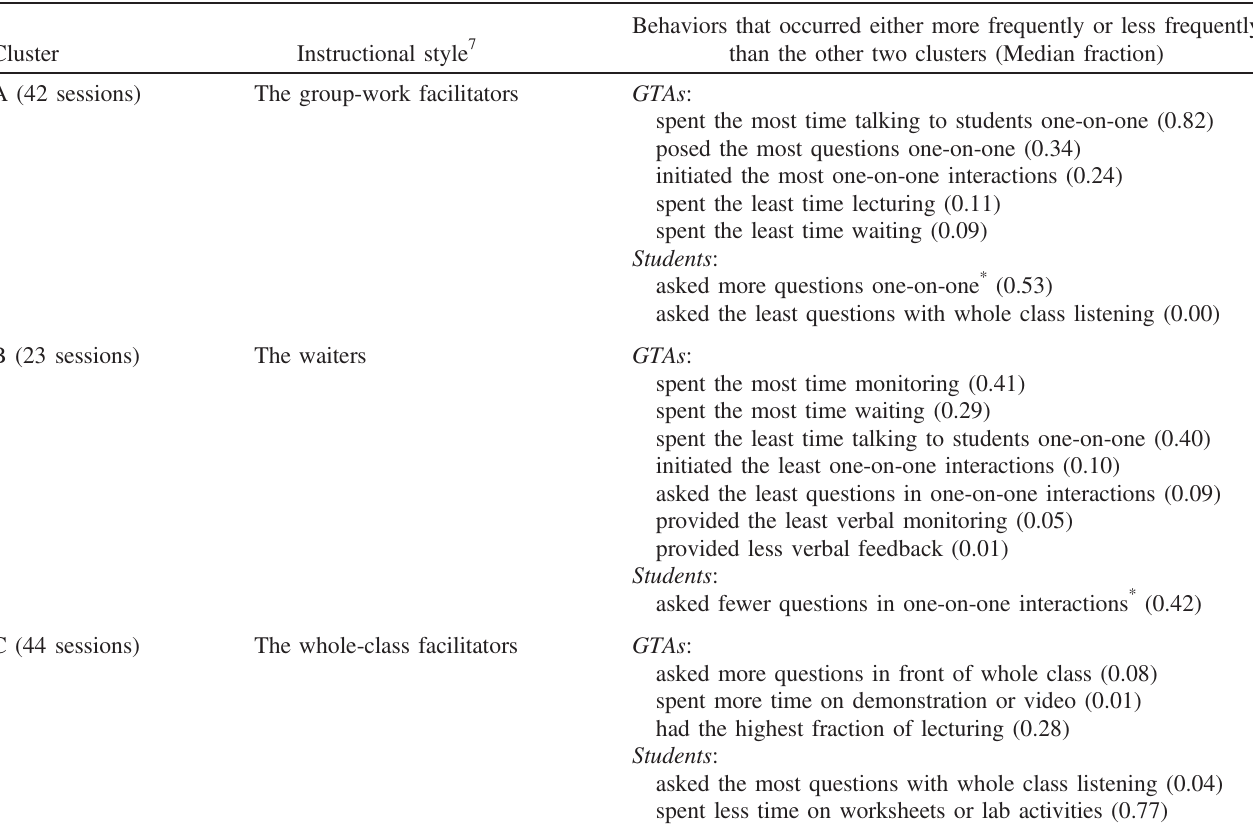
TABLE V. Definitions of GTA instructional styles characterized by codes that have medium and large effect sizes.